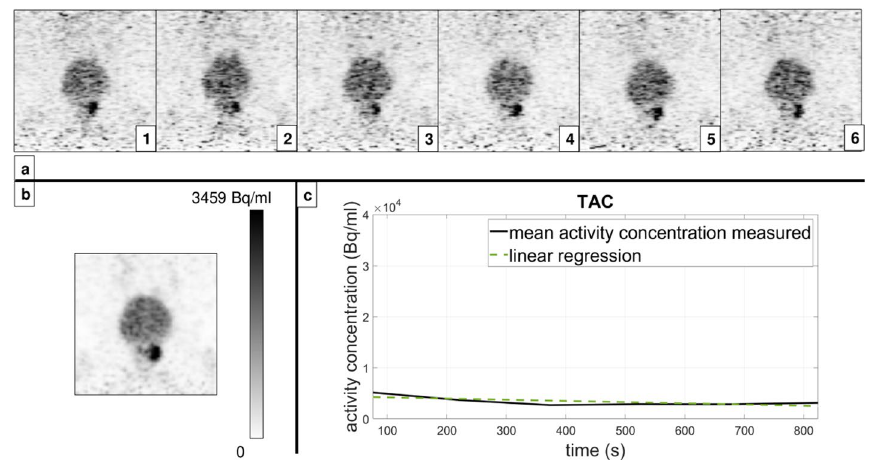
Fig. 1 68 Ga-PSMA-11 PET images (patient 22) of the prostate scanning range reconstructed in dynamic mode ( a ) and static mode ( b ) with the corresponding TAC ( c )